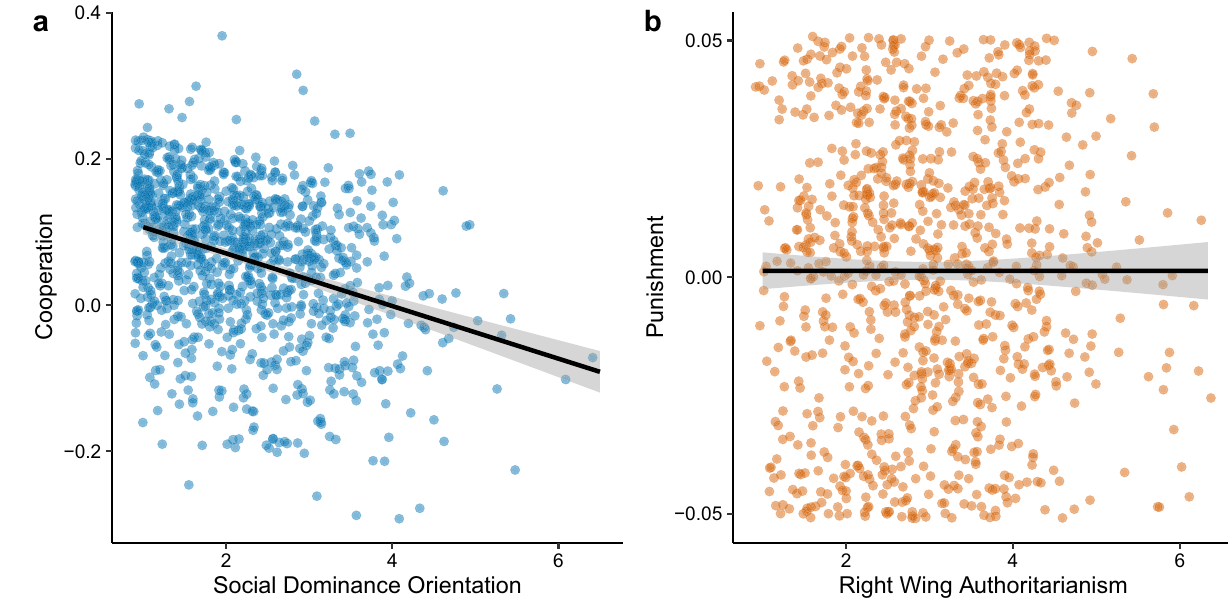
Figure 2. Relationships between model-predicted latent variable scores for cooperation and punishment and the two dimensions of political ideology. ( a ) Social Dominance Orientation (mean score) is negatively related to the cooperation latent variable. ( b ) Right Wing Authoritarianism (mean score) is unrelated to the punishment latent variable. Full lines are predictions from least-squares linear regressions without demographic covariates and shaded areas are 95% confidence intervals. Note that the latent variable scores are not raw data, but rather model predictions that are estimated with error that is not visualised in the